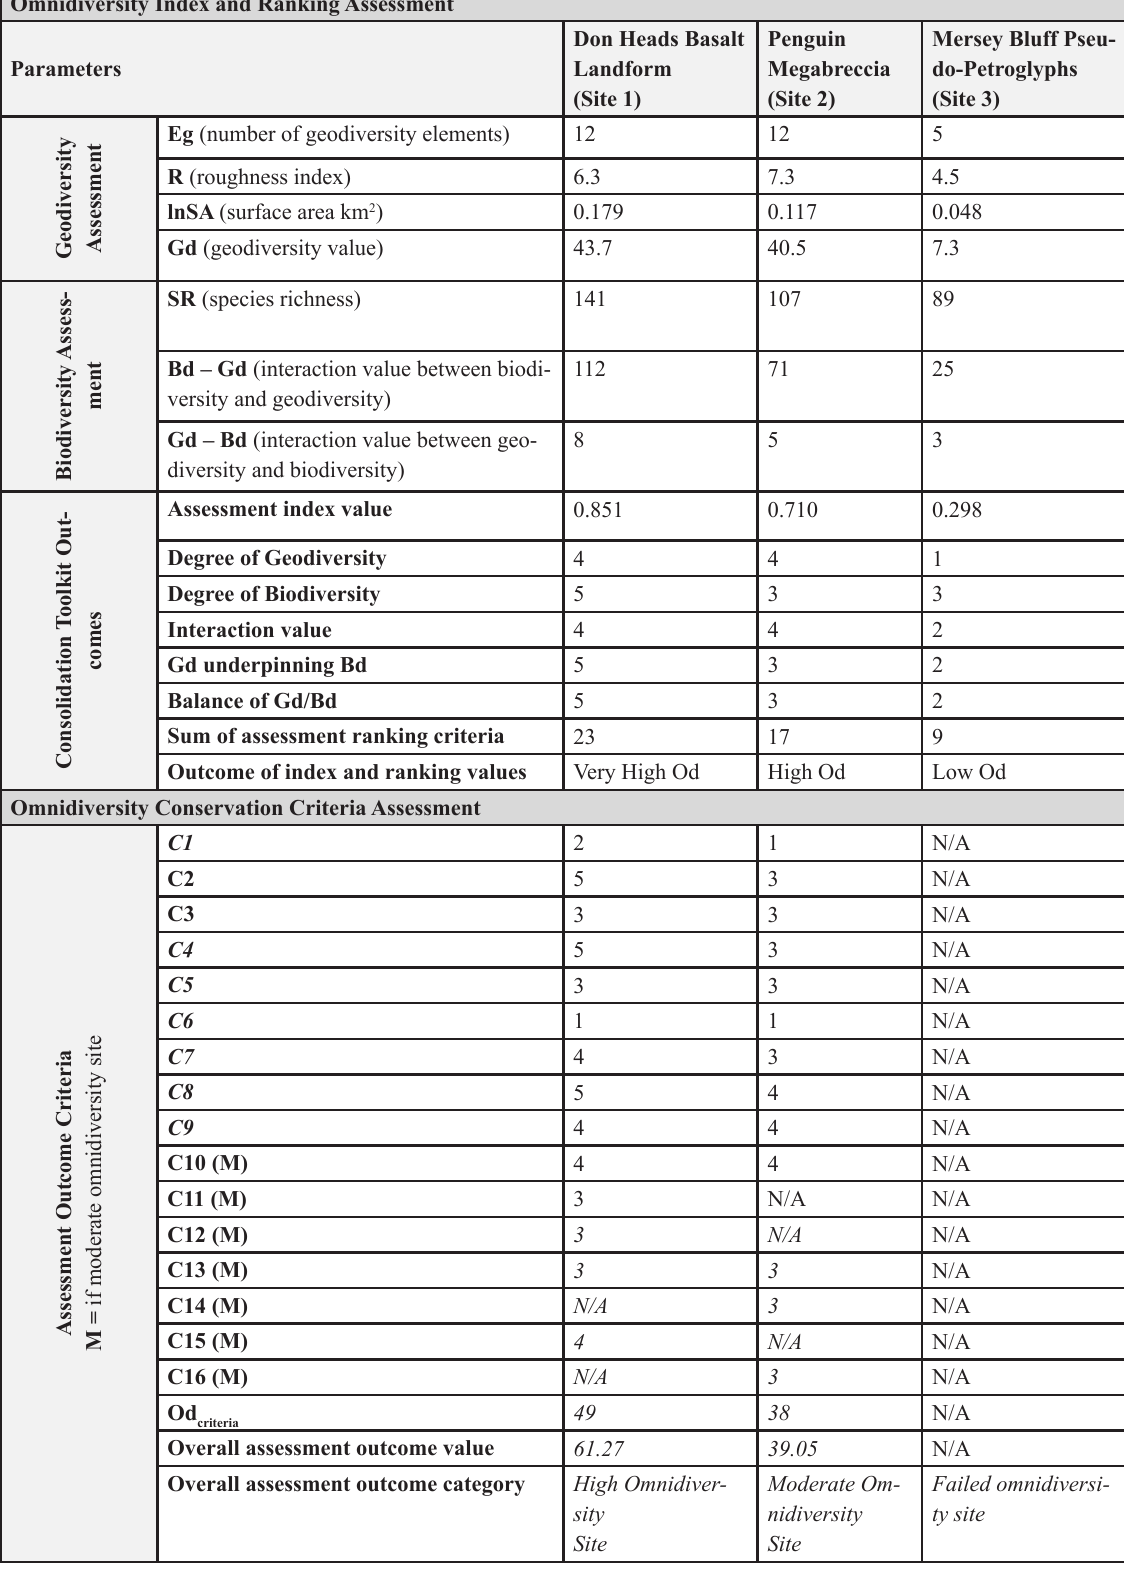
Table 2. The data acquired from the implementation of the consolidation approach at each of the geoconservation